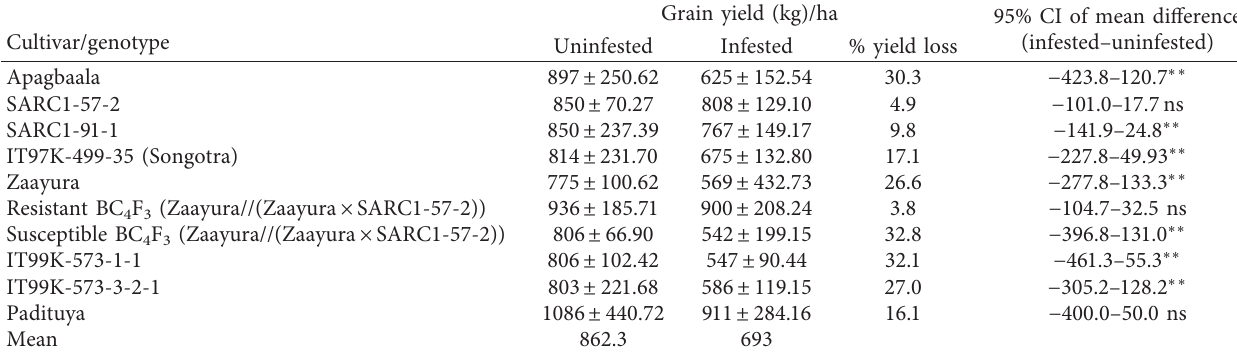
Table 6: Effect of aphid infestation on grain yield of cowpea cultivars/genotypes.